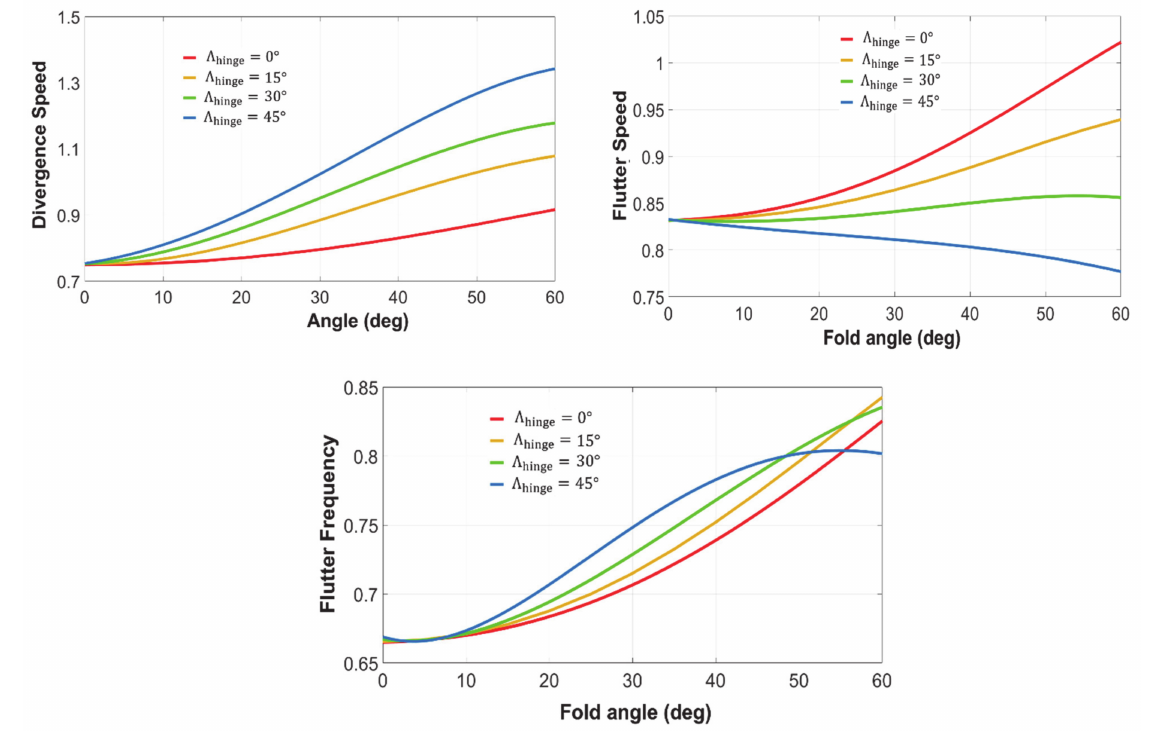
Figure 12. Variation of aeroelastic parameters for a wingtip length of 2.032